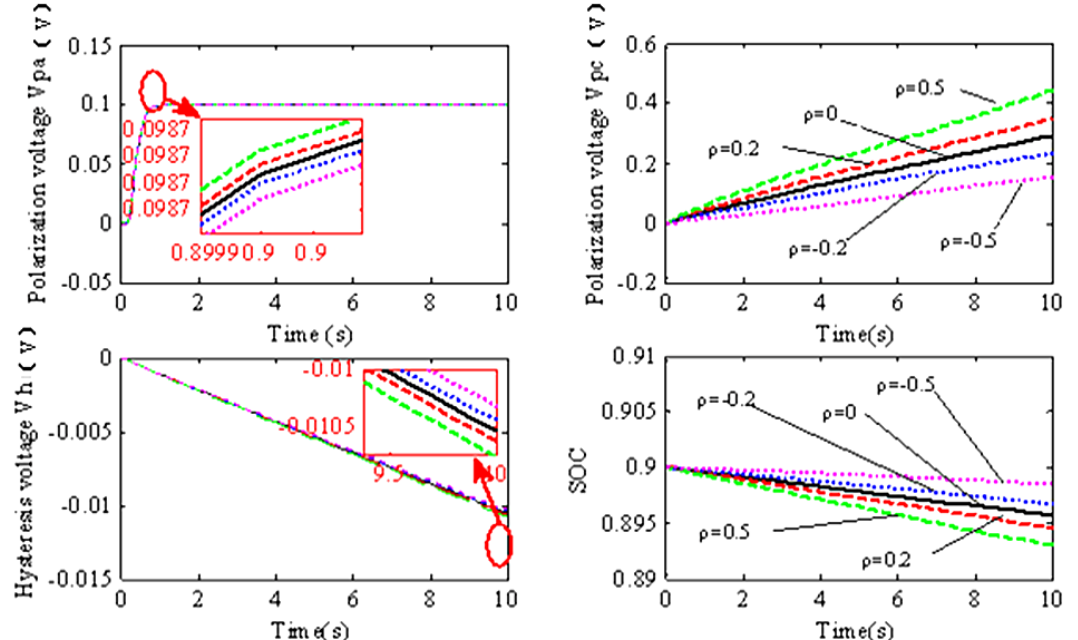
Figure 4. Impact of bias constant ρ on states